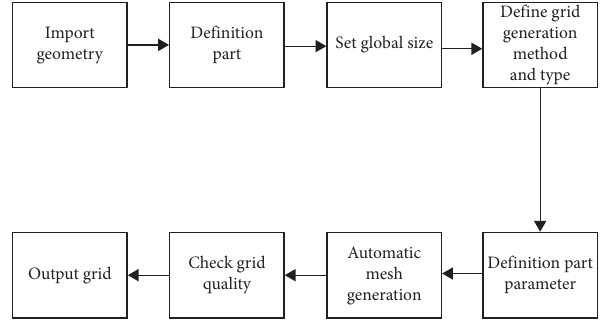
Figure 4: Unstructured mesh generation steps. Table 2: Mesh